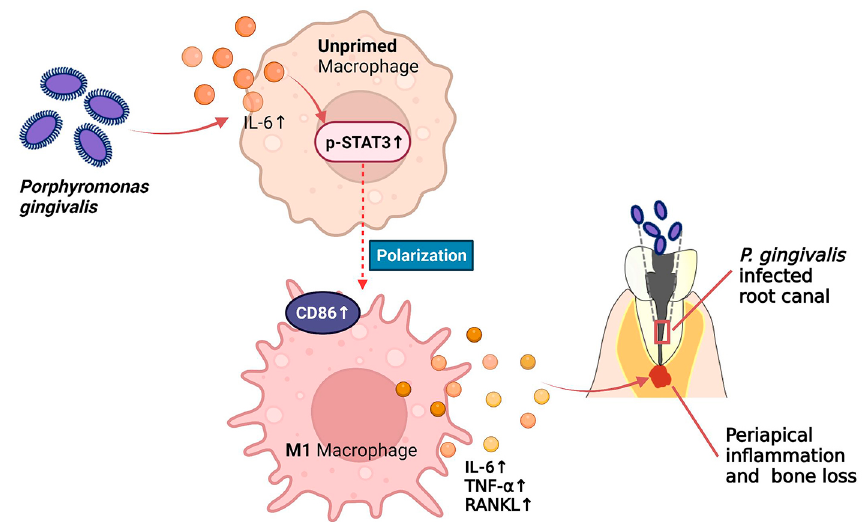
Figure 8- Schematic illustration. P. gingivalis infection polarizes macrophages toward the M1 phenotype via activating the IL-6/STAT3 pathway. The M1 macrophages accelerate apical inflammation and bone destruction via secretion of IL-6, TNF- α , and RANKL, which are pro-inflammatory mediators that can impede osteogenesis and promote